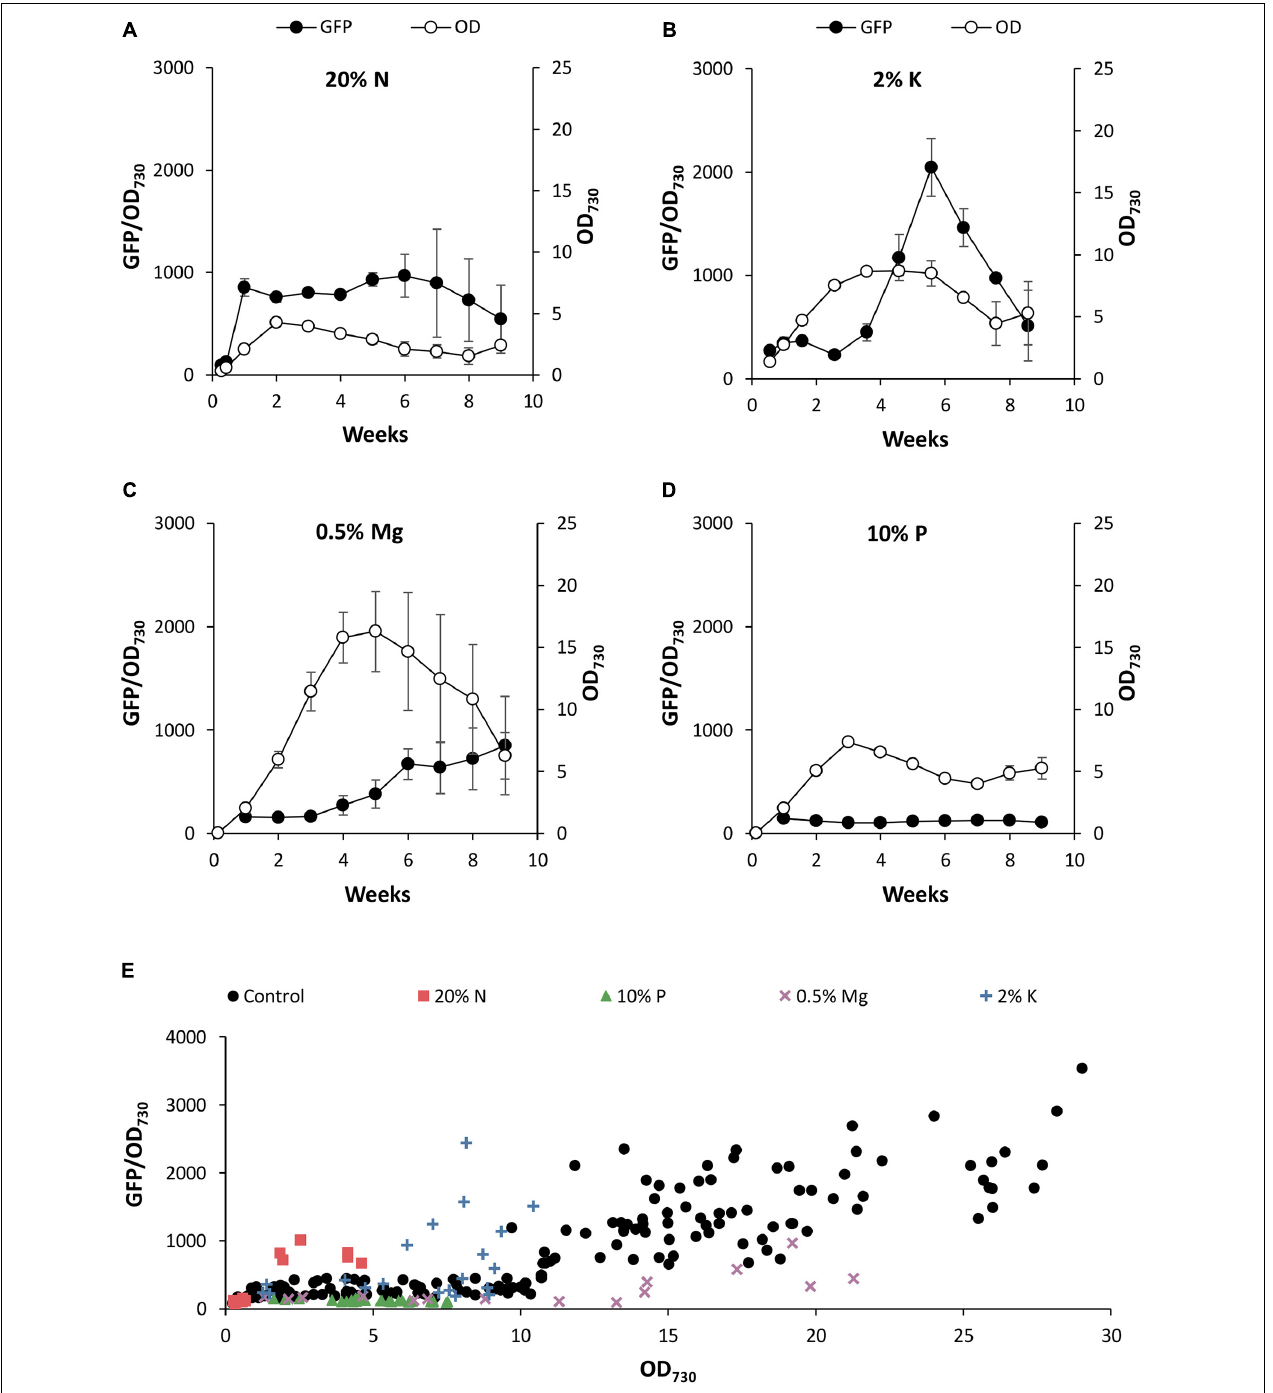
FIGURE 6 | The effect of nutrient deficiency on PndbA600 activity. PndbA600 activity (black circles, GFP fluorescence normalised to OD 730 , left axis) in Synechococcus PndbA600:GFP cultures grown under low nutrient conditions ( Supplementary Table S2 ). (A) 20% N, (B) 2% K, (C) 0.5% Mg, and (D) 10% P in A + background. Culture density (OD 730 , right axis) is shown with white circles. Data are means ± S.E.M. of three independent cultures. (E) PndbA600 activity (GFP fluorescence normalised to OD 730 ) against culture density (OD 730 ) in Synechococcus PndbA600:GFP grown in control (A+, black circles, n = 20) and low nutrient conditions (A + background; 20% N, red squares, n = 3; 10% P, green triangles, n = 3; 0.5% Mg, purple crosses, n = 3; 2% K, blue plusses, n = 3). Data represent measurements taken as culture density increased. Measurements taken after maximum culture density was achieved are not shown. For promoter activity under control conditions see Figure 4